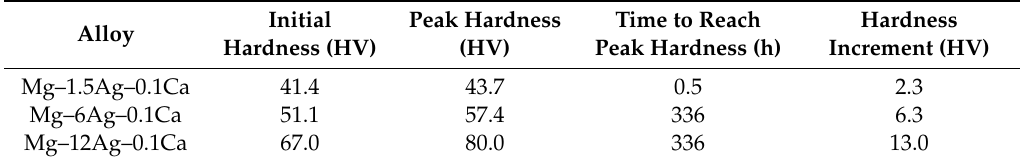
Figure 3. Age-hardening response of 1.5Ag, 6Ag and 12Ag containing alloy sheets at 170 ◦ C. Figure 3. Age ‐ hardening response of 1.5Ag, 6Ag and 12Ag containing alloy sheets at 170 °C. Table 2. Initial hardness (T4 condition), peak-hardness, time to reach peak hardness and hardness Table 2. Initial hardness (T4 condition), peak ‐ hardness, time to reach peak hardness and hardness increment of 1.5Ag, 6Ag and 12Ag containing alloy increment of 1.5Ag, 6Ag and 12Ag containing alloy sheets.